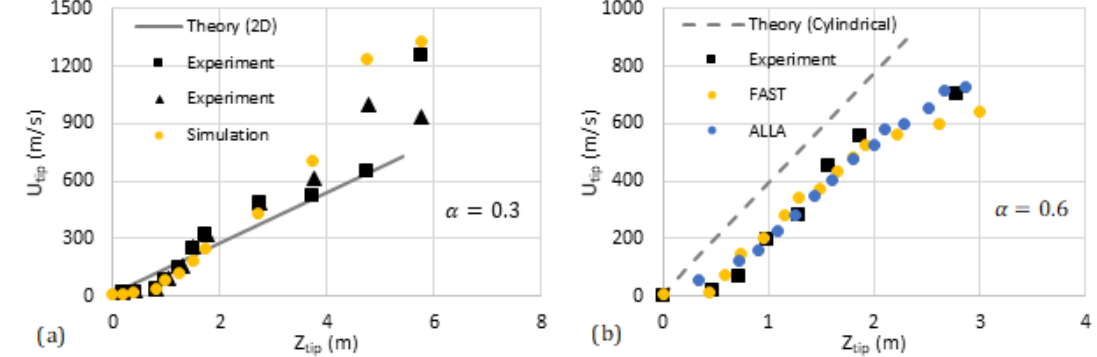
Figure 11. Comparison of our theoretical formulation with the experiments [31] and computational simulations [6] (FAST, yellow, and ALLA, blue). The flame tip velocity vs. its position for the blockage ratios (cid:2009) = 0.3 ( a ) and 0.6 ( b ).